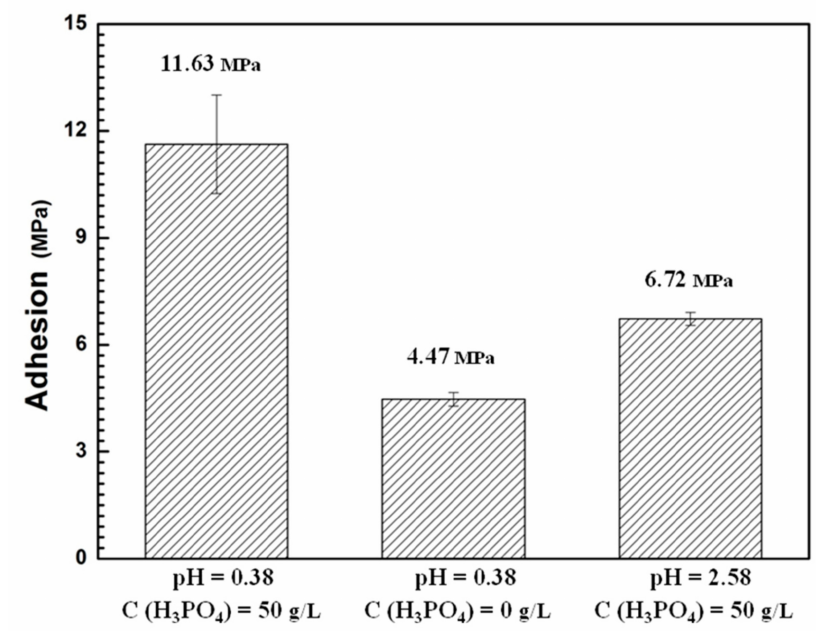
Figure 9. Influence of adhesion strength by pH and phosphate radical (bars donate